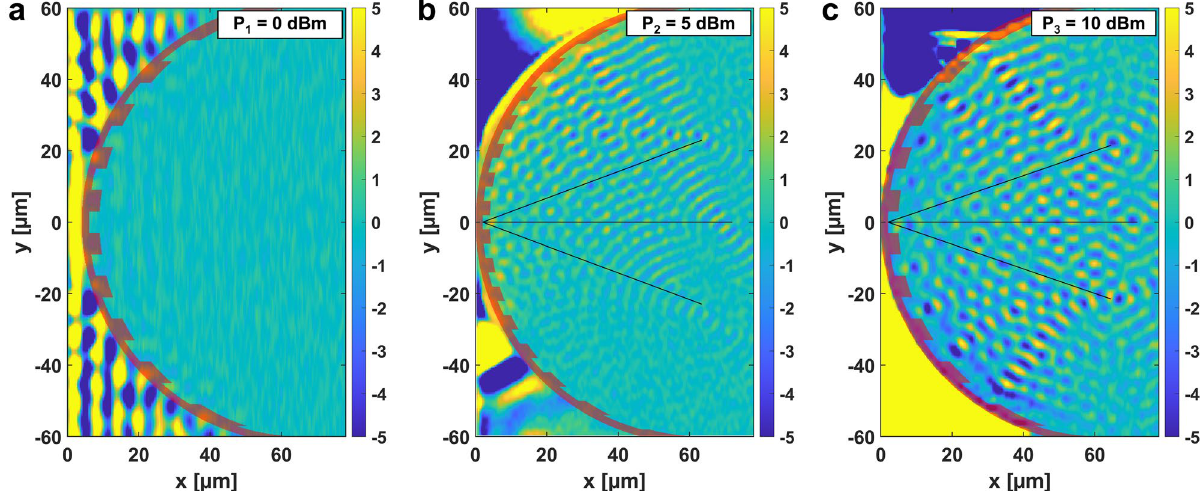
Figure 3. TrMOKE images of miscellaneous gratings expressing the difference in performance with respect to small ( a ), higher ( b ) and high ( c ) microwave current applied at the input waveguide. The right edge of the CPW ground line is 3 µm away from grating posterior in each case. The semi-transparent red overlay indicates the FIB-irradiated region, black lines show expected diffraction angles. The grating operation visibly enhances with the level of uniformity in the nonlinear spin wave excitation behind the FIB